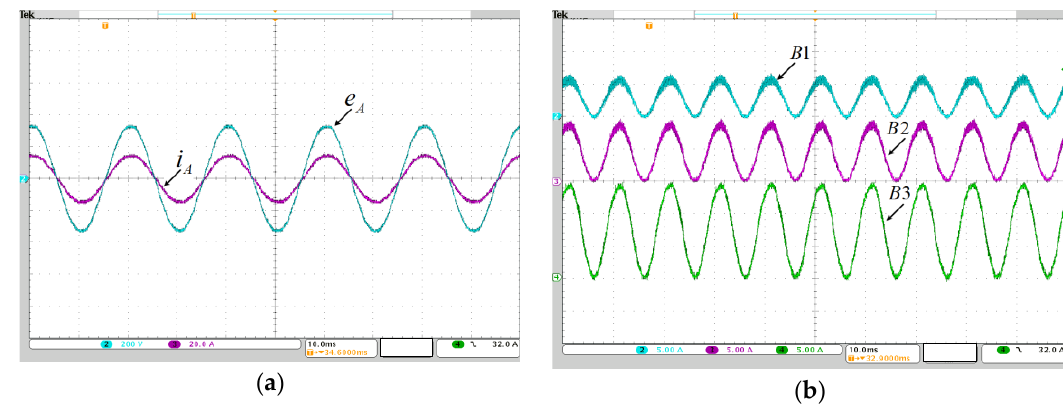
Figure 12. Waveforms of flexible groups during charge: ( a ) AC current and voltage in phase A; and ( b ) DC current of each module in phase B.